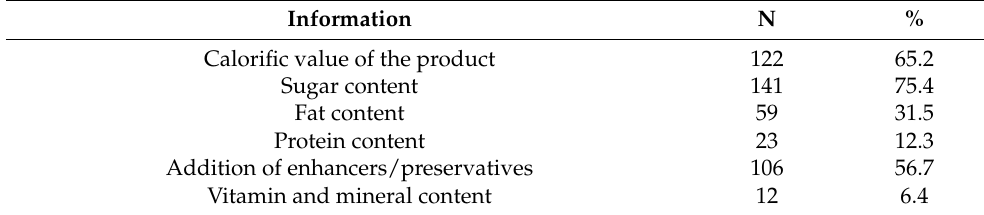
Table 3. Types of information sought on a product label (N; %).